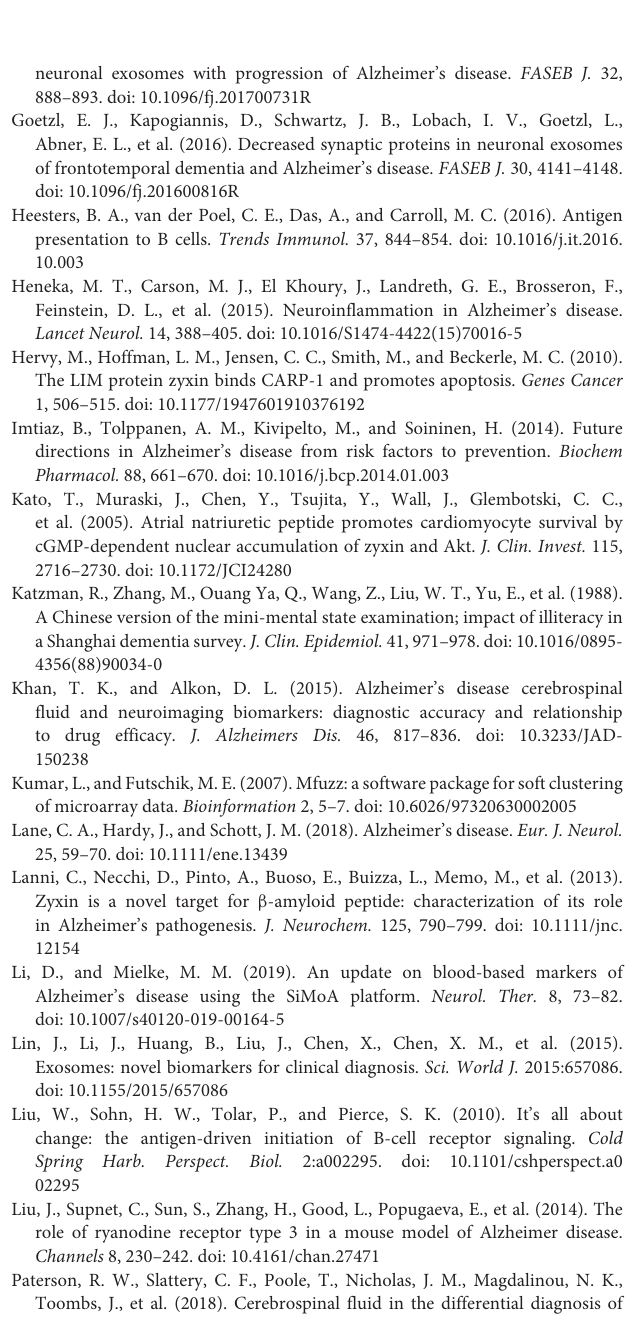
SUPPLEMENTARY TABLE 4 | Detailed results of the DEPs between different stages of cognitive decline. SUPPLEMENTARY TABLE 5 | Phenotypic information of all subjects in ELISA validation